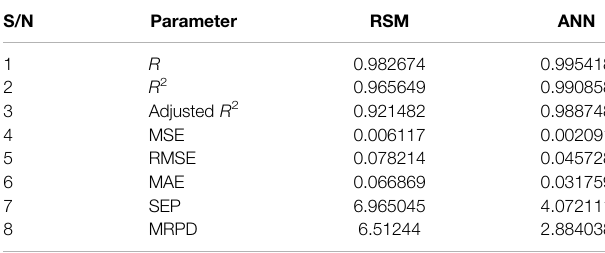
TABLE 7 | Comparative performance evaluation of RSM and ANN models.